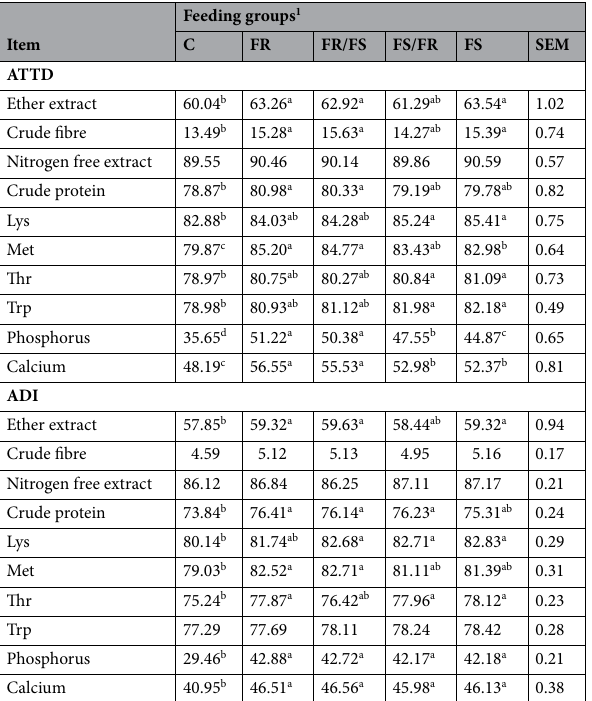
Table 3. Apparent total tract digestibility (ATTD) and apparent ileum digestibility (AID) coefficients (%) of nutrients and selected minerals in piglets. a,b,c,d Values in rows marked with different letters differ significantly at p ≤ 0.05. 1 Feeding groups: C—control; FR- group receiving a diet with 8% FRSM; FR/FS—group receiving a diet with 6% FRSM and 2% FSBM; FS/FR—group receiving a diet with 6% FSBM and 2% FRSM; FS—group receiving a diet with 8% FSBM.